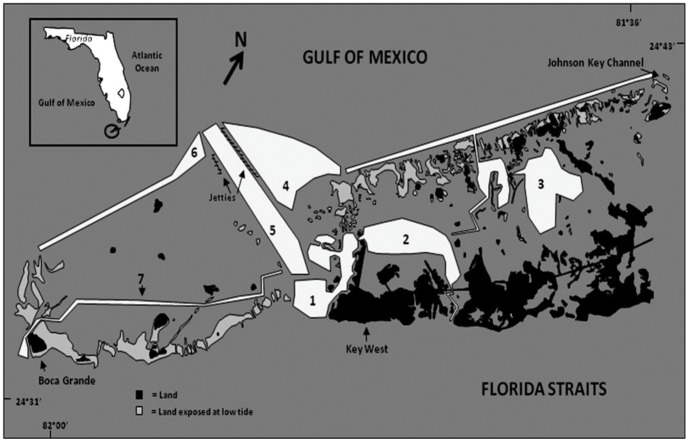
Lower Florida Keys research area.Numbered zones within the study area include all navigable waters.